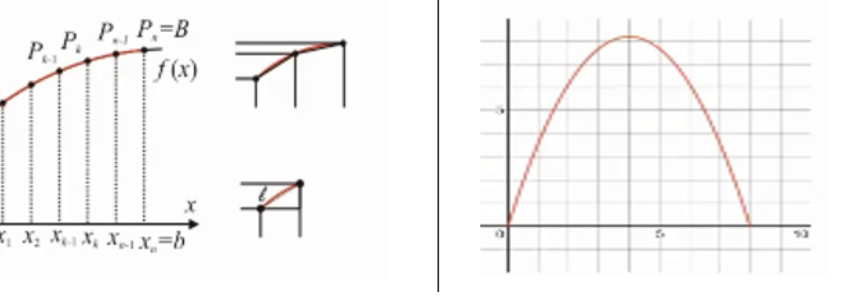
Figure 10. Length of a parabola arc representation. Table 2. Length of a parabola arc.